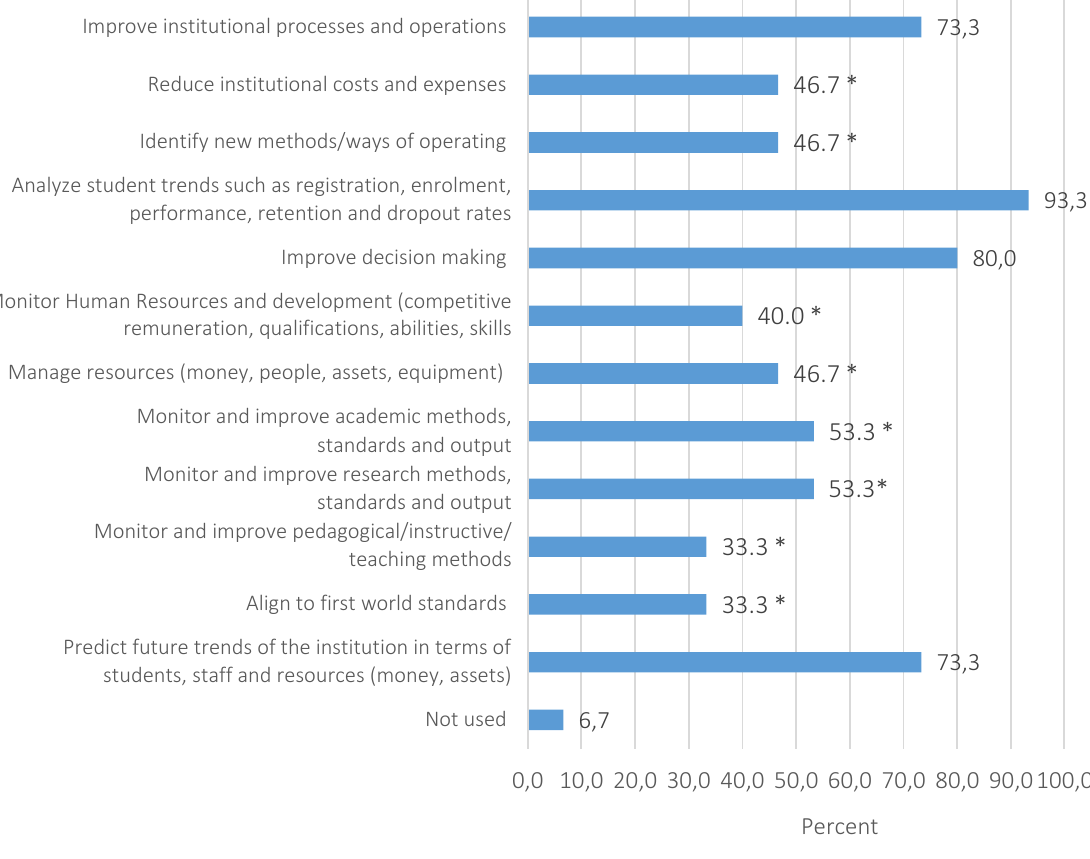
Figure 3. Strategic use of knowledge management at the respondents’ institutions Table 3. Types of Knowledge Management Information Systems used and frequency of use Least frequent Seldom